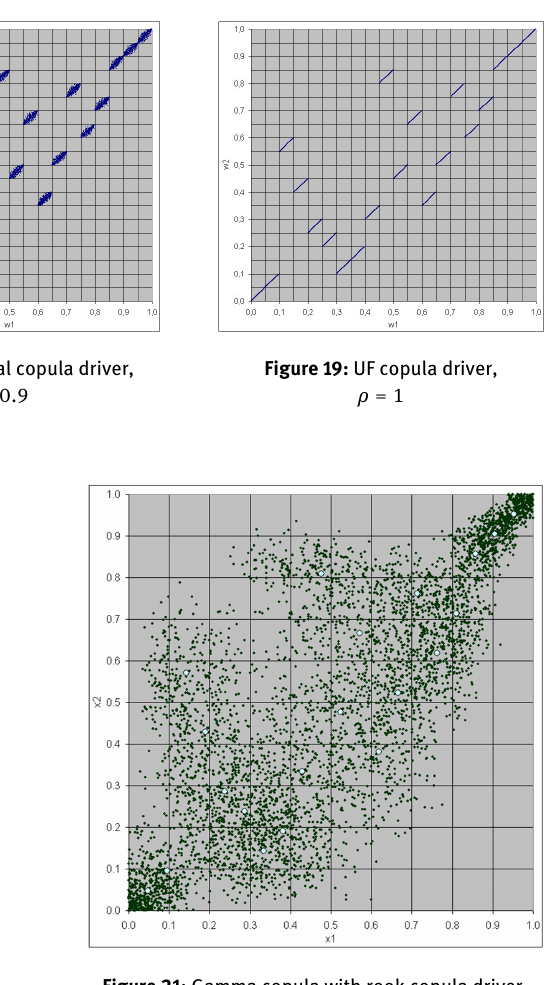
Figure 20: Gamma copula with rook copula driver, Figure 21: Gamma copula with rook copula driver,